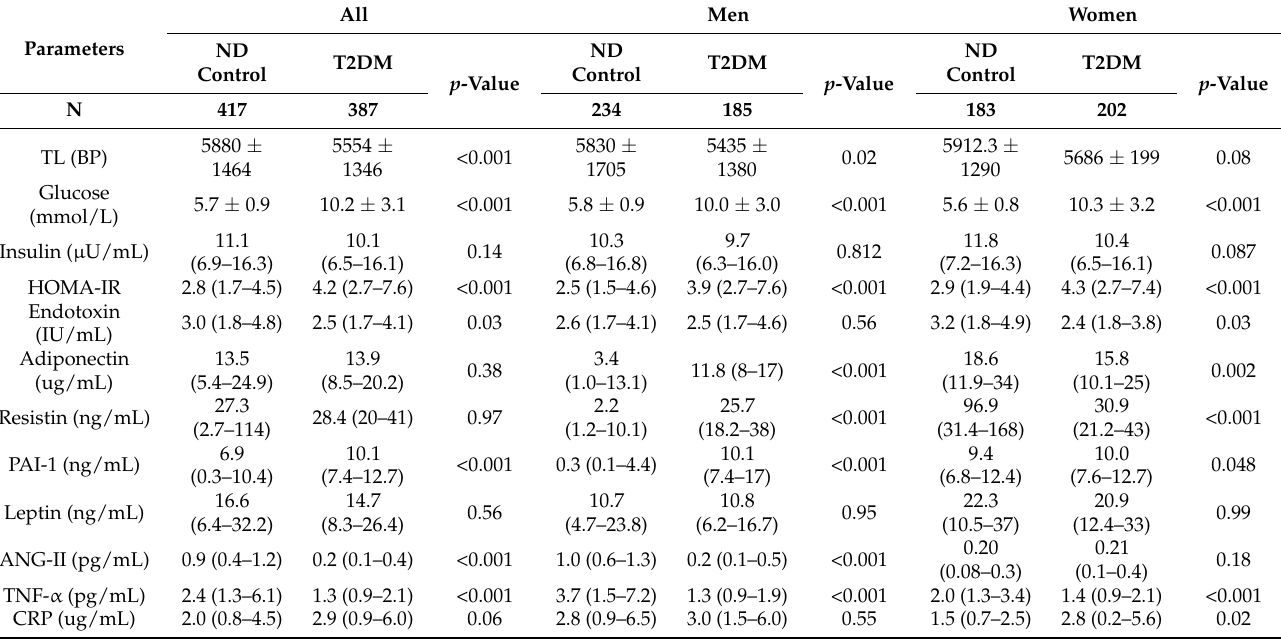
Table 3. Telomere length, glycemic profile, and pro-inflammatory markers in participants with or without T2DM.